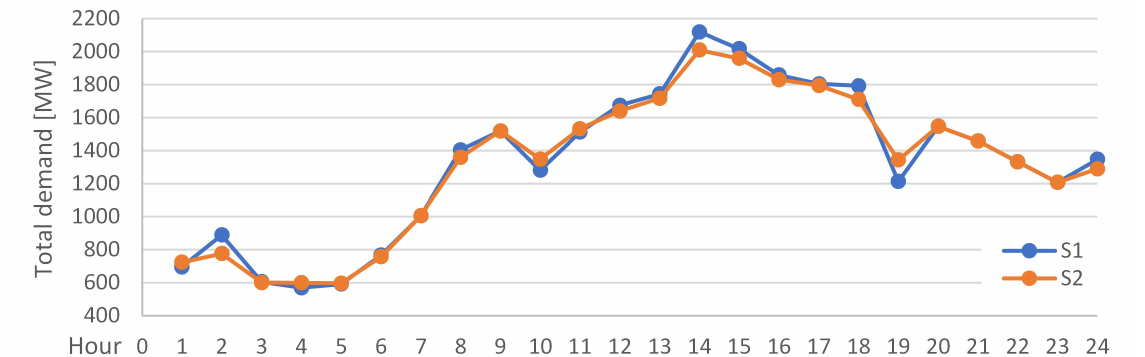
Figure 10. Total demand, including DS in scenario S1 (business as usual) and S2 (flexibility